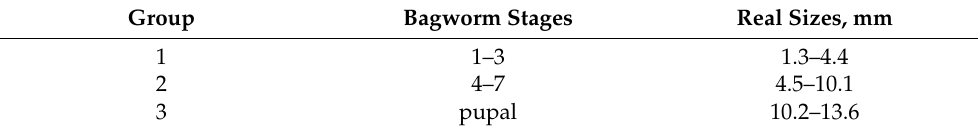
Table 1. Bagworm classification corresponding to real sizes subjected to the stages of development.